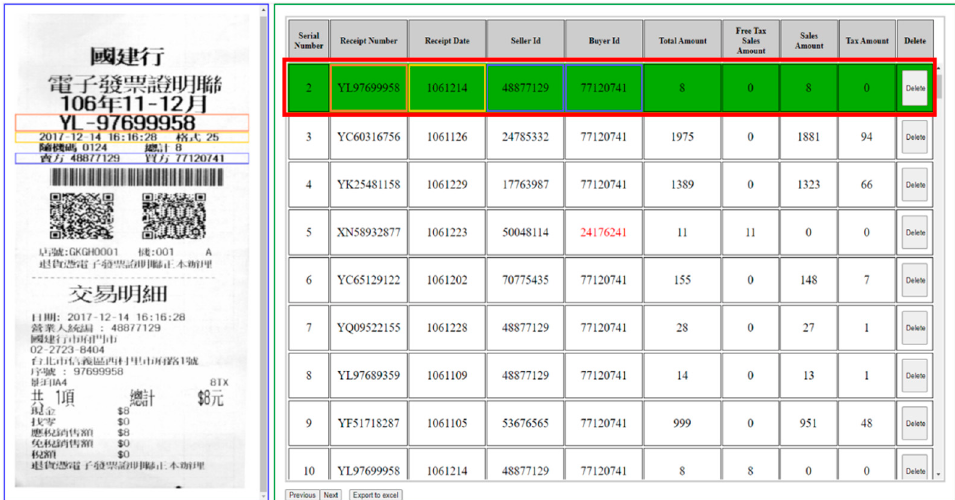
Figure 22. System interface for printed receipts .